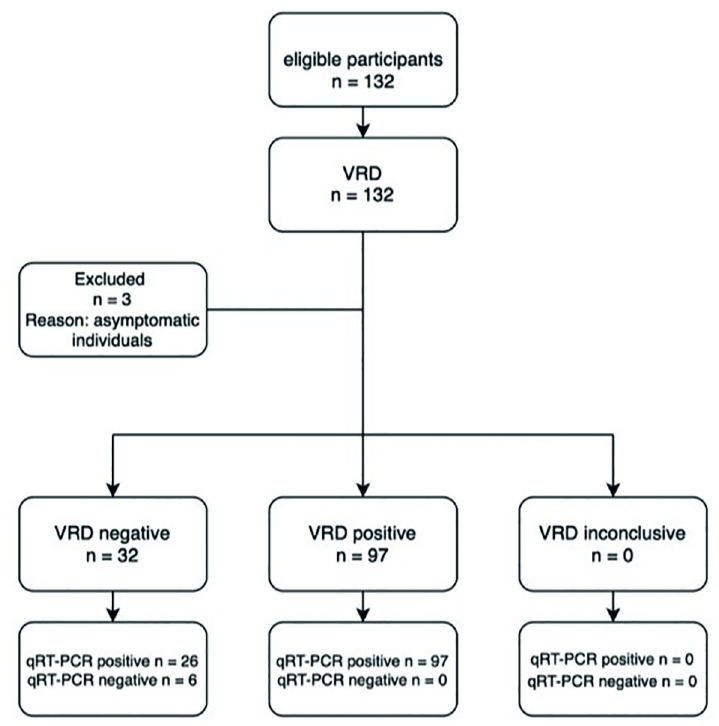
Fig 2. Diagram for the flow of participants for part 2 of the study (qRT-PCR positive participants only).